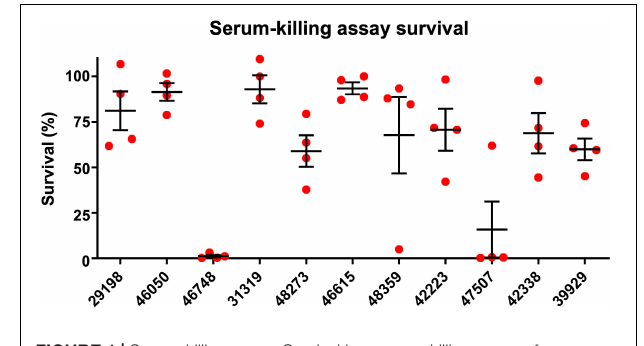
FIGURE 1 | Serum-killing assay. Survival in a serum-killing assay of K. pneumoniae strains isolated from blood cultures of patients with bloodstream infections at a Chinese hospital. The survival is denoted in percentage. The bars denote means and standard errors of the mean.